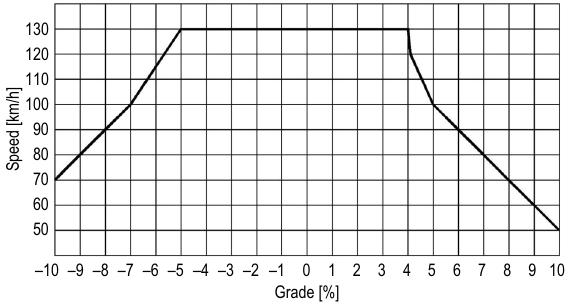
Fig. 4. Relation between the longitudinal grade and the speed (Putevi Srbije